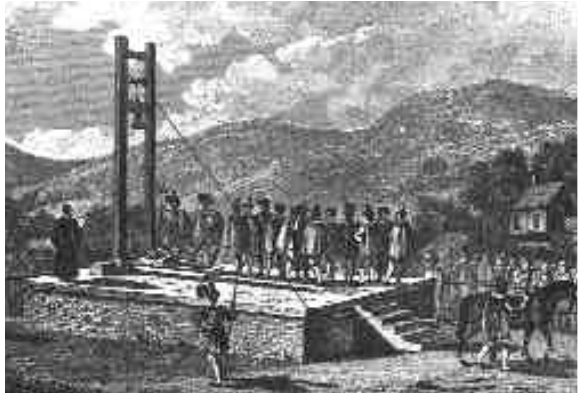
Fig. 2. The Halifax